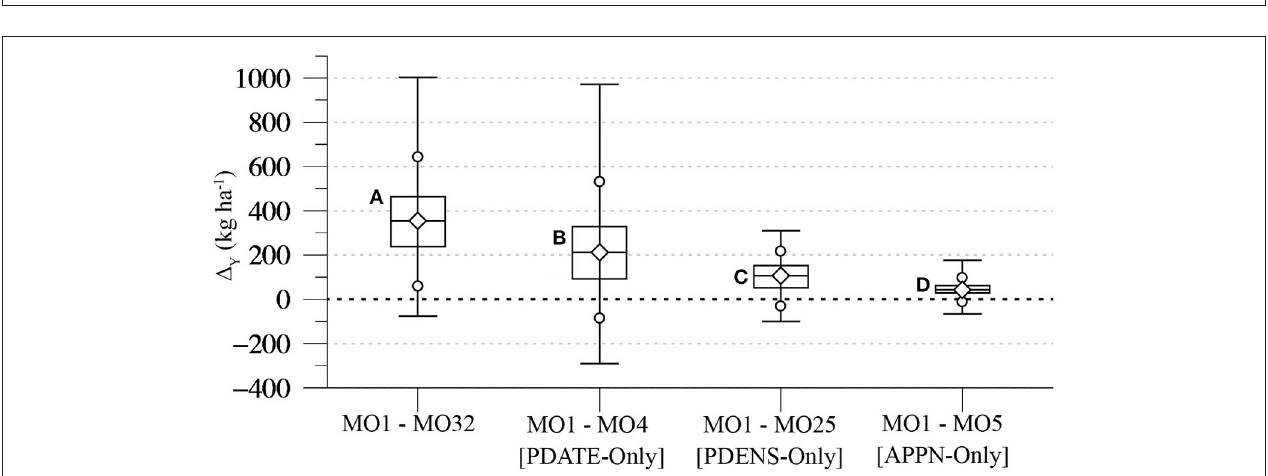
FIGURE 5 | (A) Distribution of yield effect ( 1 Y ) values resulting from subtracting lint yields generated via the MO32 management option from the lint yield generated via the MO1 option using the same station-year’s weather data. (B) As in (A) for 1 Y values generated by subtracting MO4 from MO1 yields. (C) As in (A) for 1 Y values generated by subtracting MO25 from MO1 yields. (D) As in (A) for 1 Y values generated by subtracting MO5 from MO1 yields.